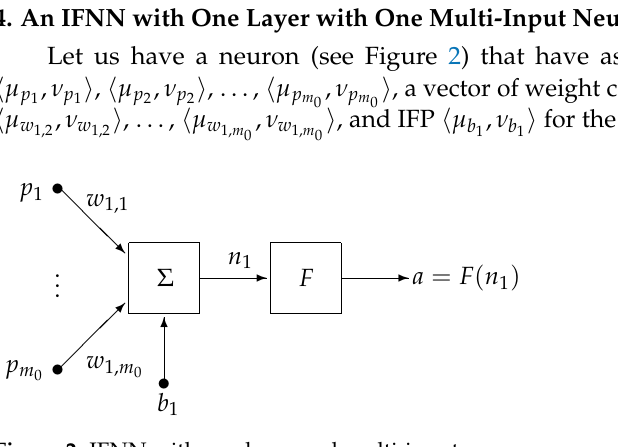
Figure 2. IFNN with one layer and multi-input neuron.